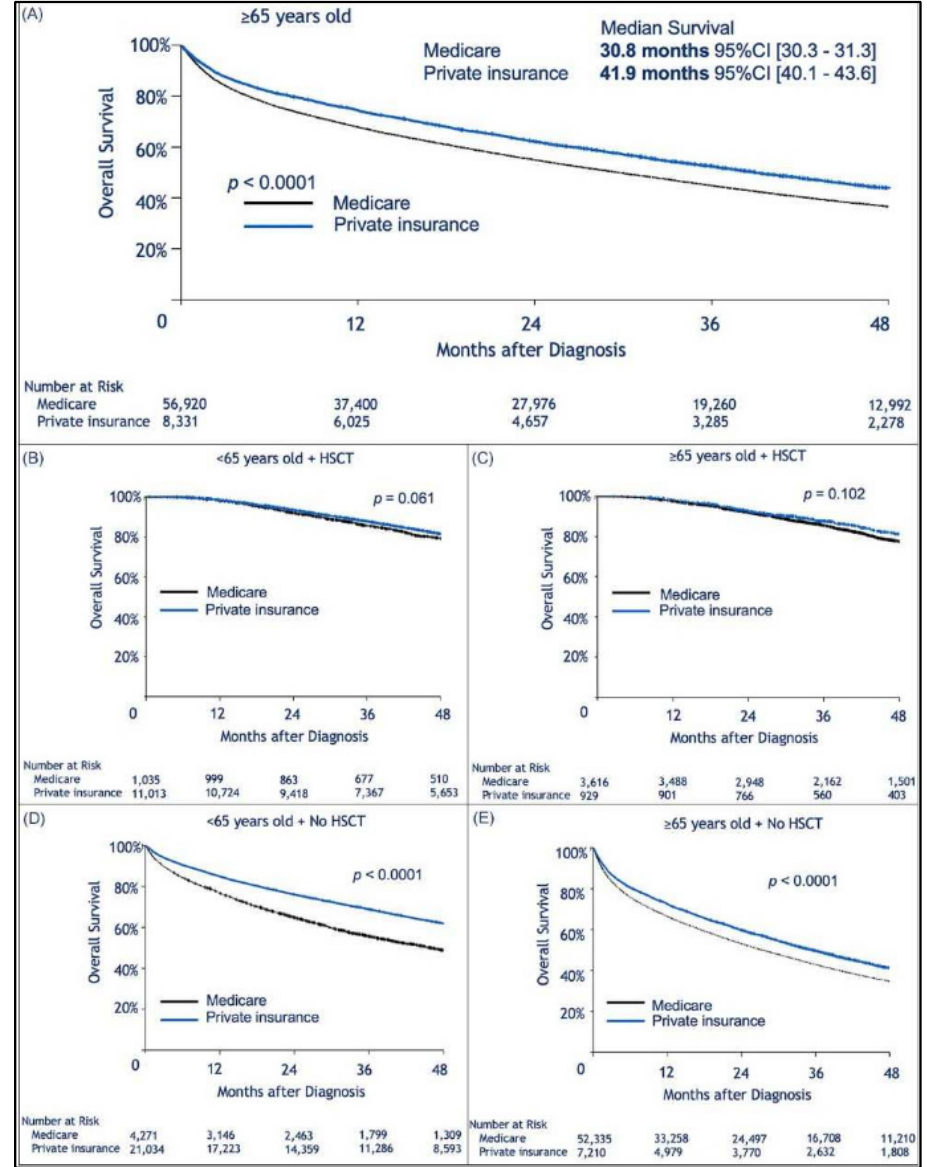
Figure 1. Kaplan–Meier estimation of overall survival comparing patients insured by Medicare or with private insurance. In ( A ) Among patients aged ≥ 65 years, private insurance was associated with longer survival; ( B , C ) No insurance-related difference in survival was observed for patients who received an autologous transplant. In ( B ), patients younger than 65 years old who received Hematopoietic Stem Cell Transplantation (HSCT), and in ( C ), patients ≥ 65 years old who received HSCT; however, for patients who did not receive a transplant, the influence of insurance type was again present. In ( D ), patients younger than 65 years old who did not undergo autologous transplant, and in ( E ) patients ≥ 65 years old who did not receive autologous transplant. There were racial differences in the insurance coverage type. For patients self-identified as black, there was a lower proportion of Medicare (47% vs. 55%; p < 0.0001), and private insurance (33% vs. 35%; p = 0.0008) and a higher percentage of Medicaid (10% vs. 4%; p < 0.0001) or uninsured patients (6% vs. 2%; p < 0.0001) compared to patients self-identified as white. A larger proportion of blacks had a Charlson score ≥ 1 (28.7 vs. 22.9 in whites; p < 0.0001) and lived in low-income regions (76.1% vs. 56.4% of whites; p < 0.0001). How- ever, unadjusted OS was longer for African Americans compared to whites (50.6 months (95% CI: 49.1–52.3) vs. 46 months (95% CI: 45.4–46.6), respectively, ( p < 0.0001)) as